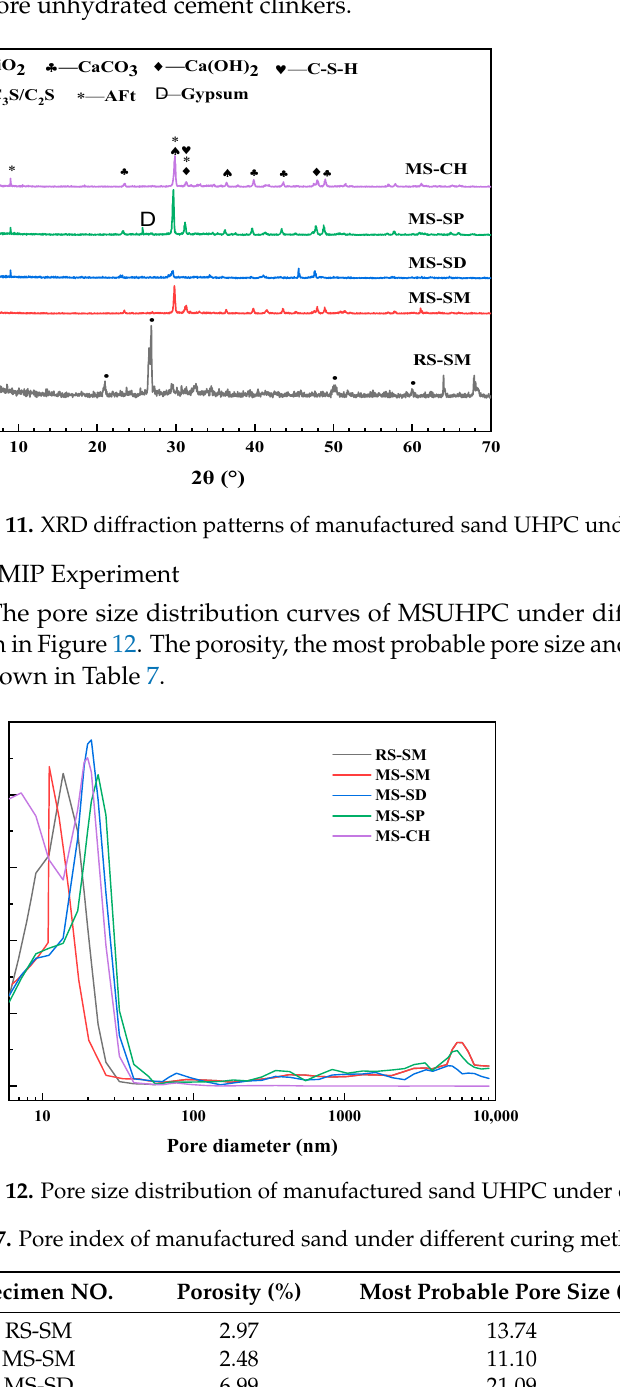
( f ) Figure 10. SEM images of manufactured sand UHPC samples under different curing methods. ( a ) RS ‐ SM; ( b ) MS ‐ SM; ( c ) MS ‐ CH; ( d ) MS ‐ SD; ( e ) MS ‐ SP; ( f ) MS ‐ SP. 3.3.2. XRD Experiment